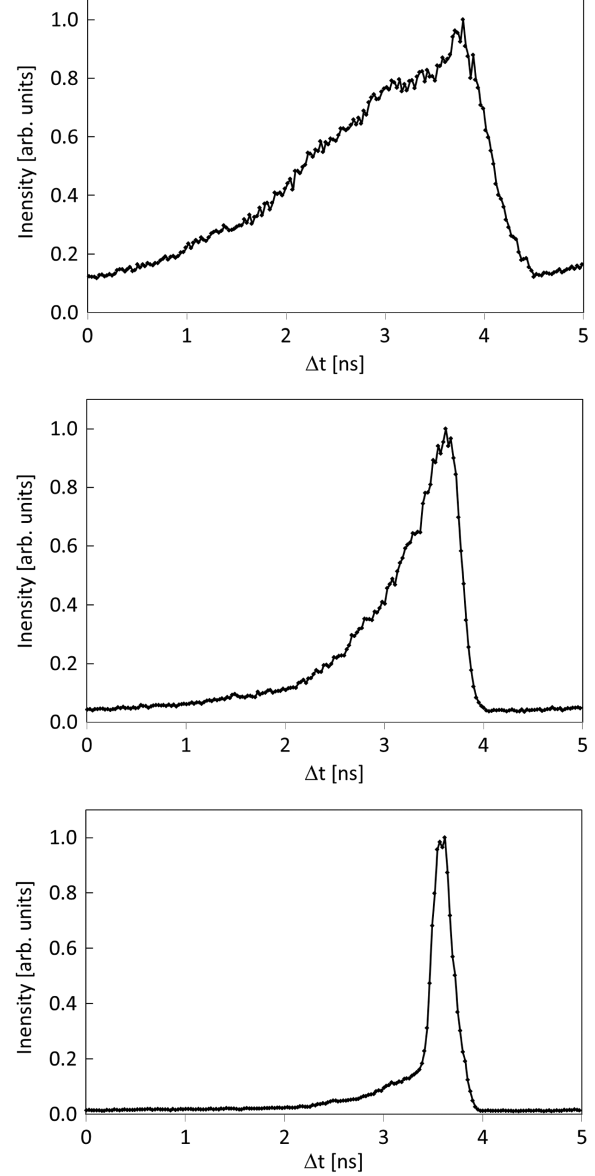
FIG. 13. Selected bunch structure for Ar 9 þ at a gradient of 3 . 5 MV/m for an rf phase of 190°, 200° and 220° according to Fig.